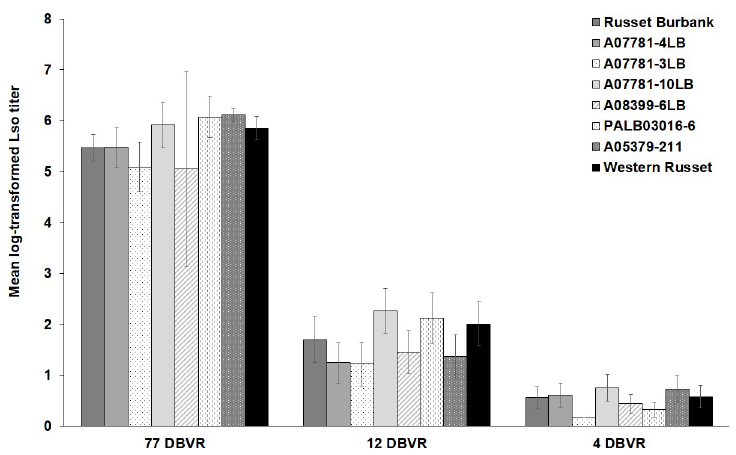
Fig 2. Mean log-transformed Lso titer in potato genotypes infested at 77, 12 or 4 days before vine removal (DBVR). Lso quantity was analyzed in tuber samples at harvest. Russet Burbank was used as the susceptible control. Error bars represent standard error ( ±